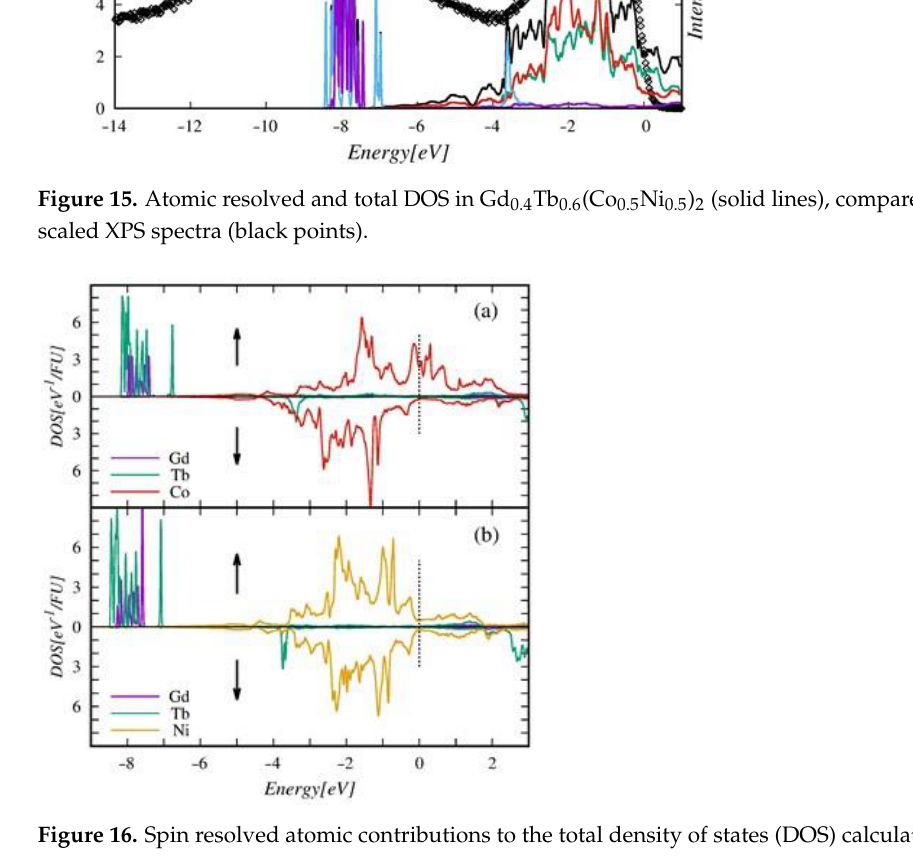
Figure 15. Atomic resolved and total DOS in Gd 0 . 4 Tb 0 . 6 (Co 0 . 5 Ni 0 . 5 ) 2 (solid lines), compared with the scaled XPS spectra (black points).